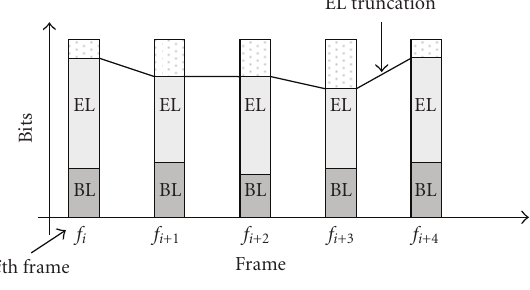
Figure 3: Example of rate control applied to FGS bitstream.